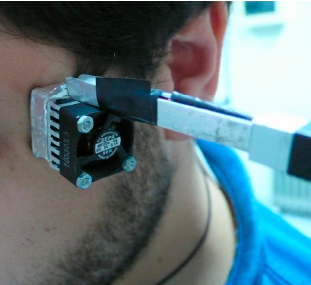
Figure 11. Sensor application to the skin.